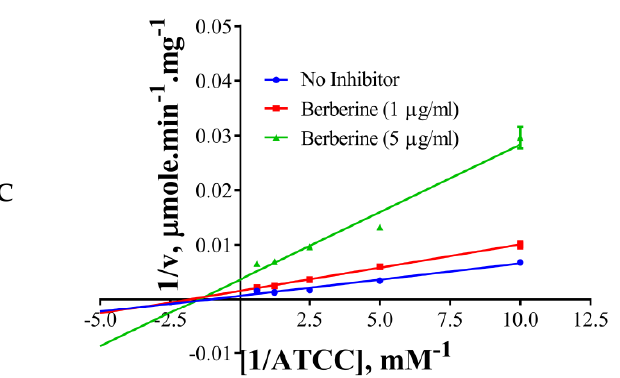
Figure 4. Lineweaver–Burkplots of AChE ( A ) in the absence or presence of galantamine hydrobromide, ( B ) in the absence or presence of palmatine, and ( C ) in the absence or presence of berberine. Experiments were performed in triplicates.